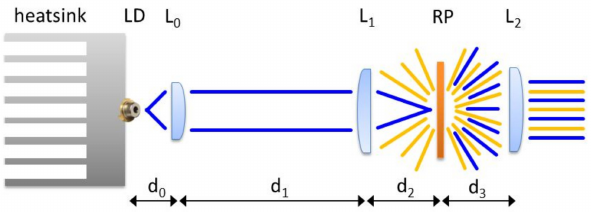
Figure 9. Schematic structure of the transmitted LARP